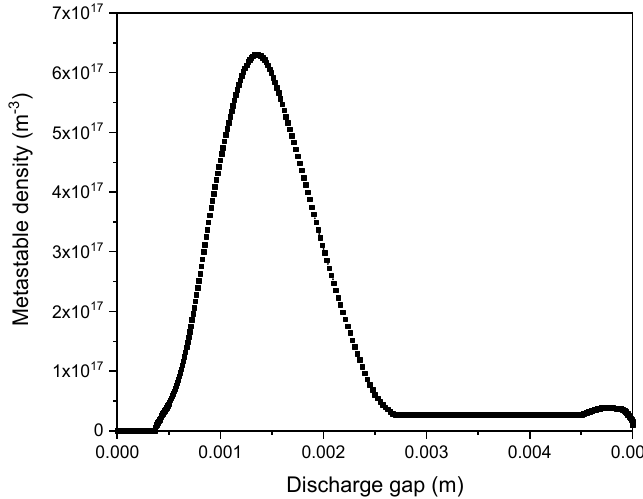
Figure 5. Metastable density (He*) spatial distribution at maximum discharge current.